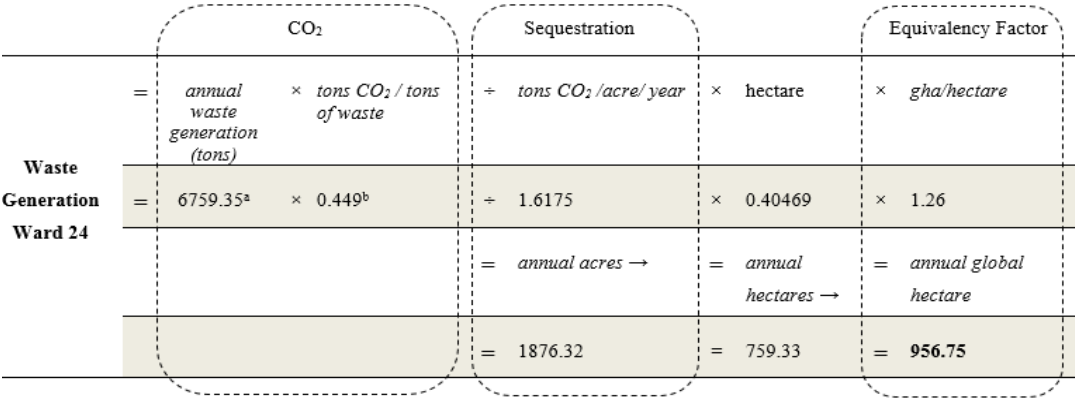
Figure 10. Waste generation rate footprint calculation and derivation. Source: a Waste Generation Rate (Survey 2015) for the population of 2015 of Ward 24 Residential Area. b [65].